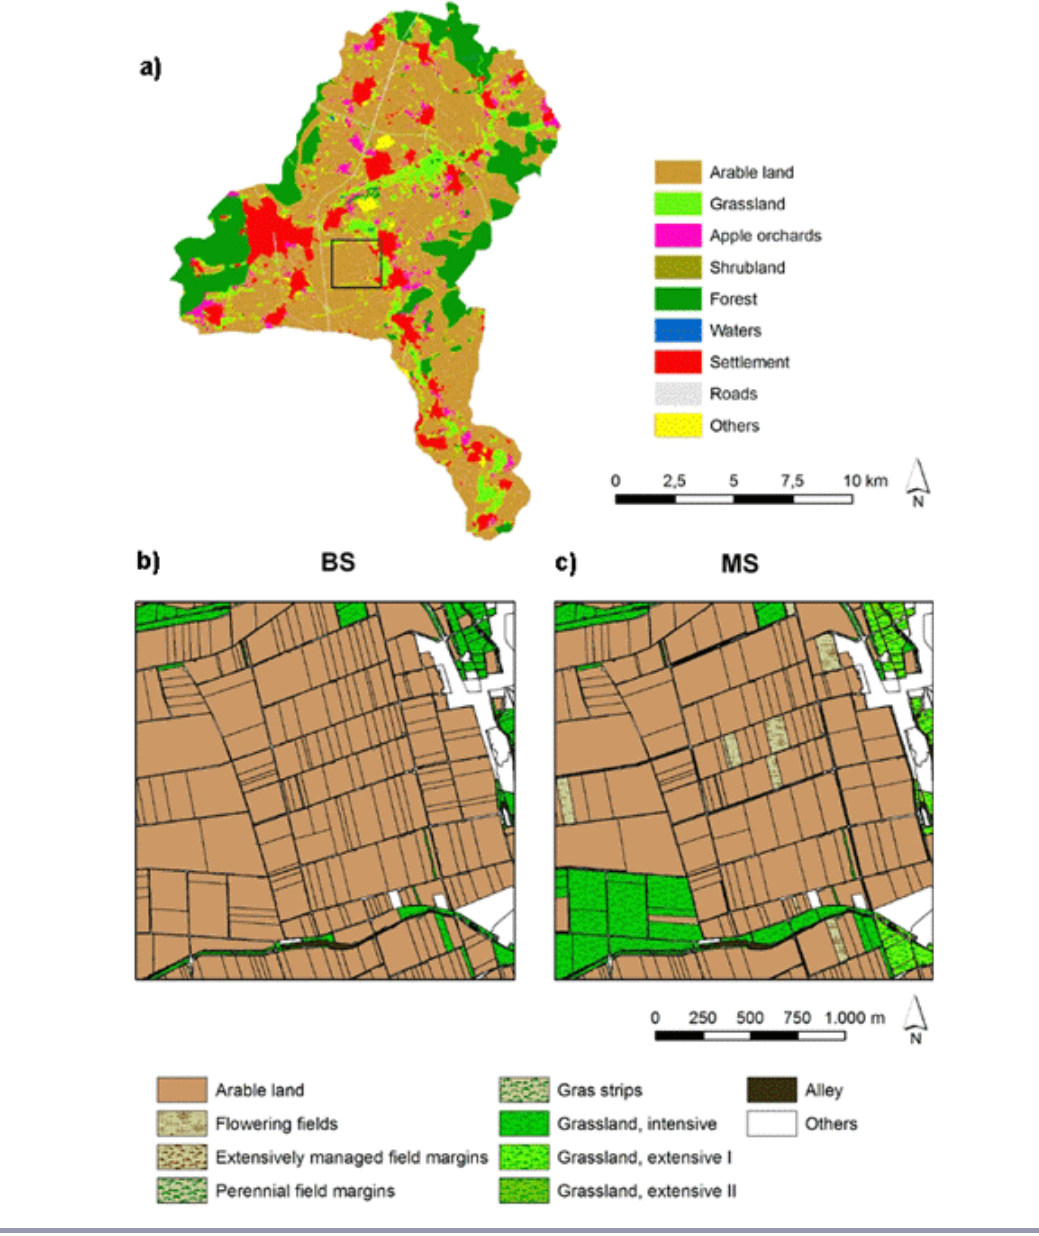
Fig. 1 . Pattern of land cover/land use classes in the study area. (a) Land cover classes of the BS. (b, c) Land use classes of the BS and the MS in an exemplary